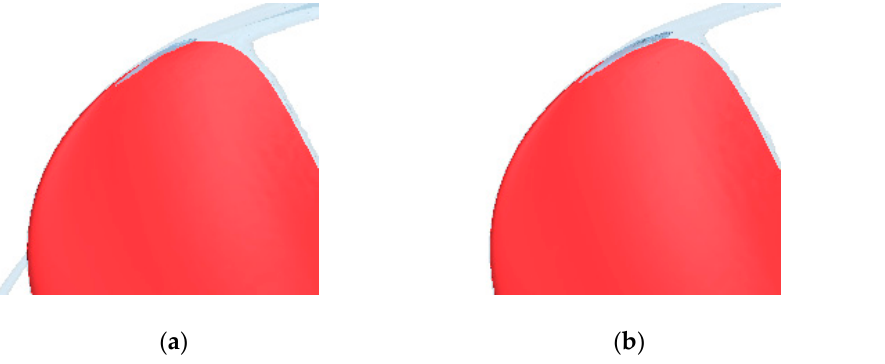
The contours of the vorticity magnitude and iso-surface of the Q-Criteria ( Q = 1/2 || ω || 2 − ||D’|| 2 ) for composite propellers (models 1 and 5) in the cavitating flow at the same rotation speed are shown in Figure 14, where ω and D’ are the vorticity tensor and rate-of-strain tensor, respectively. The strength of the tip vortex from the model 5 propel- ler was weaker than that of the model 1 propeller. The sound pressure levels of the rigid and composite propellers in the cavitating flow were compared, as shown in Figures 15 and 16. ( a )